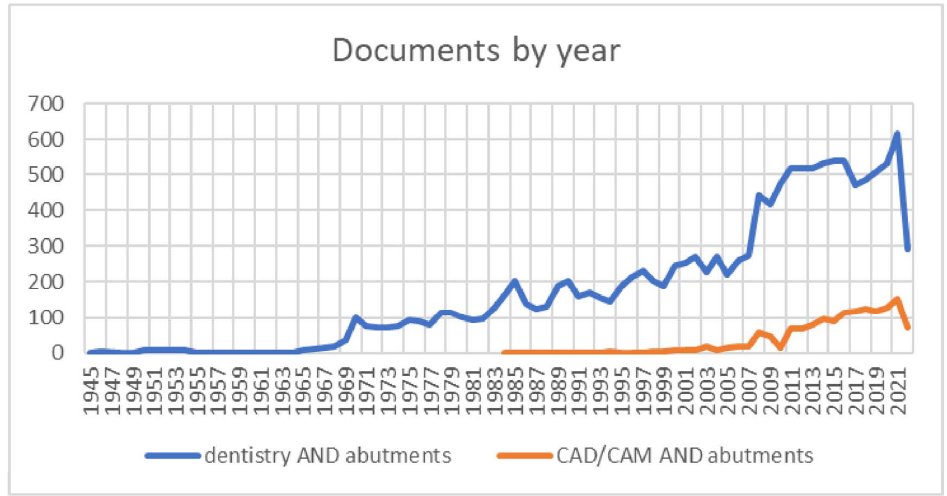
Figure 1. Number of research papers published up to 2022. Until the 1980s, before the introduction of CAD/CAM, only standard abutments